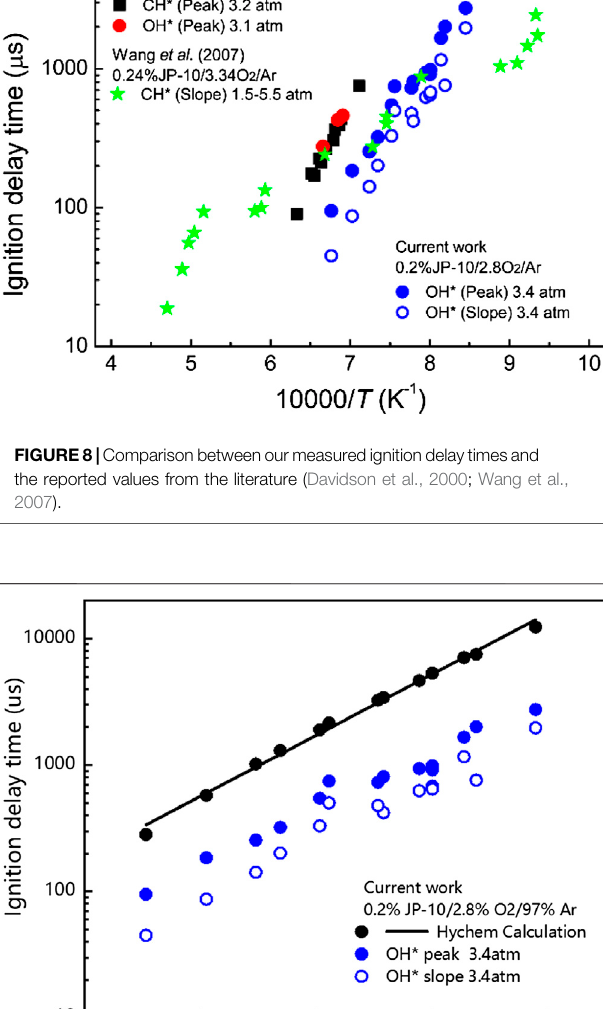
Frontiers in Energy Research |